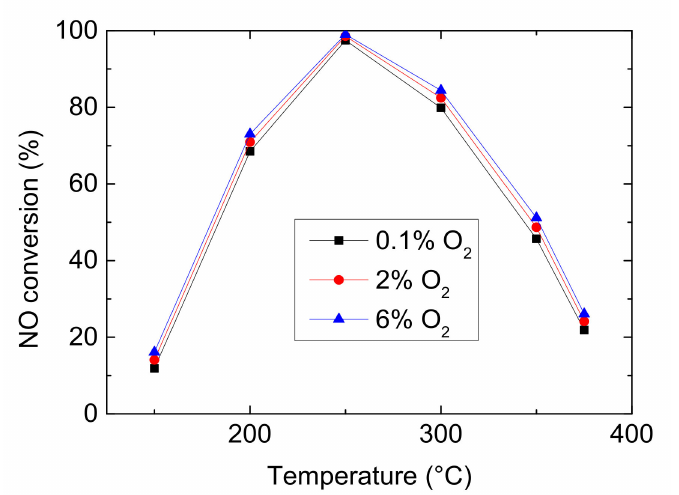
Figure 3. Effect of C O2 on NO conversion (Reaction temperature T = 150–375 ◦ C, Concentration C NH3 = C NO = 750 ppm, without H 2